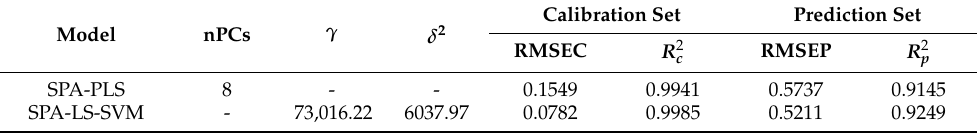
Table 4. Prediction parameters of SPA-PLS and SPA-LS-SVM based on characteristic wavelength variables for the grating spectrograph